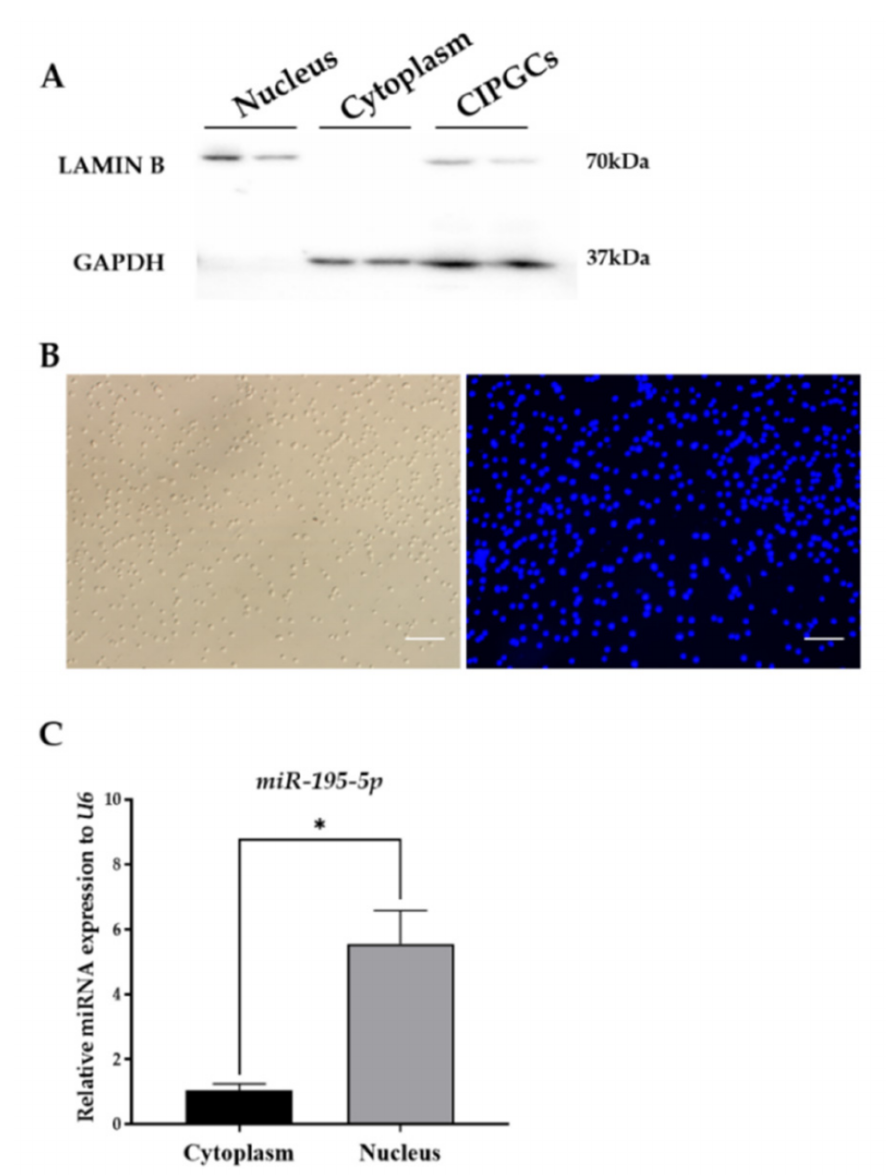
Figure 1. miR-195-5p is highly expressed in the nucleus of conditional immortalized porcine granu- losa cell (CIPGCs) line. ( A ) Western blot assay showing the quality of the cytoplasmic and nuclear components isolated from CIPGCs. ( B ) Hoechst 33,342 staining identifying the nuclei isolated from CIPGCs (scale bar 100 µ m). ( C ) RT-qPCR showing miR-195-5p levels in both cytoplasmic and nuclear components isolated from CIPGCs. Data are presented as mean ± SEM of three repeated experiments (n = 6 per group each time). * indicates p < 0.05 when compared with